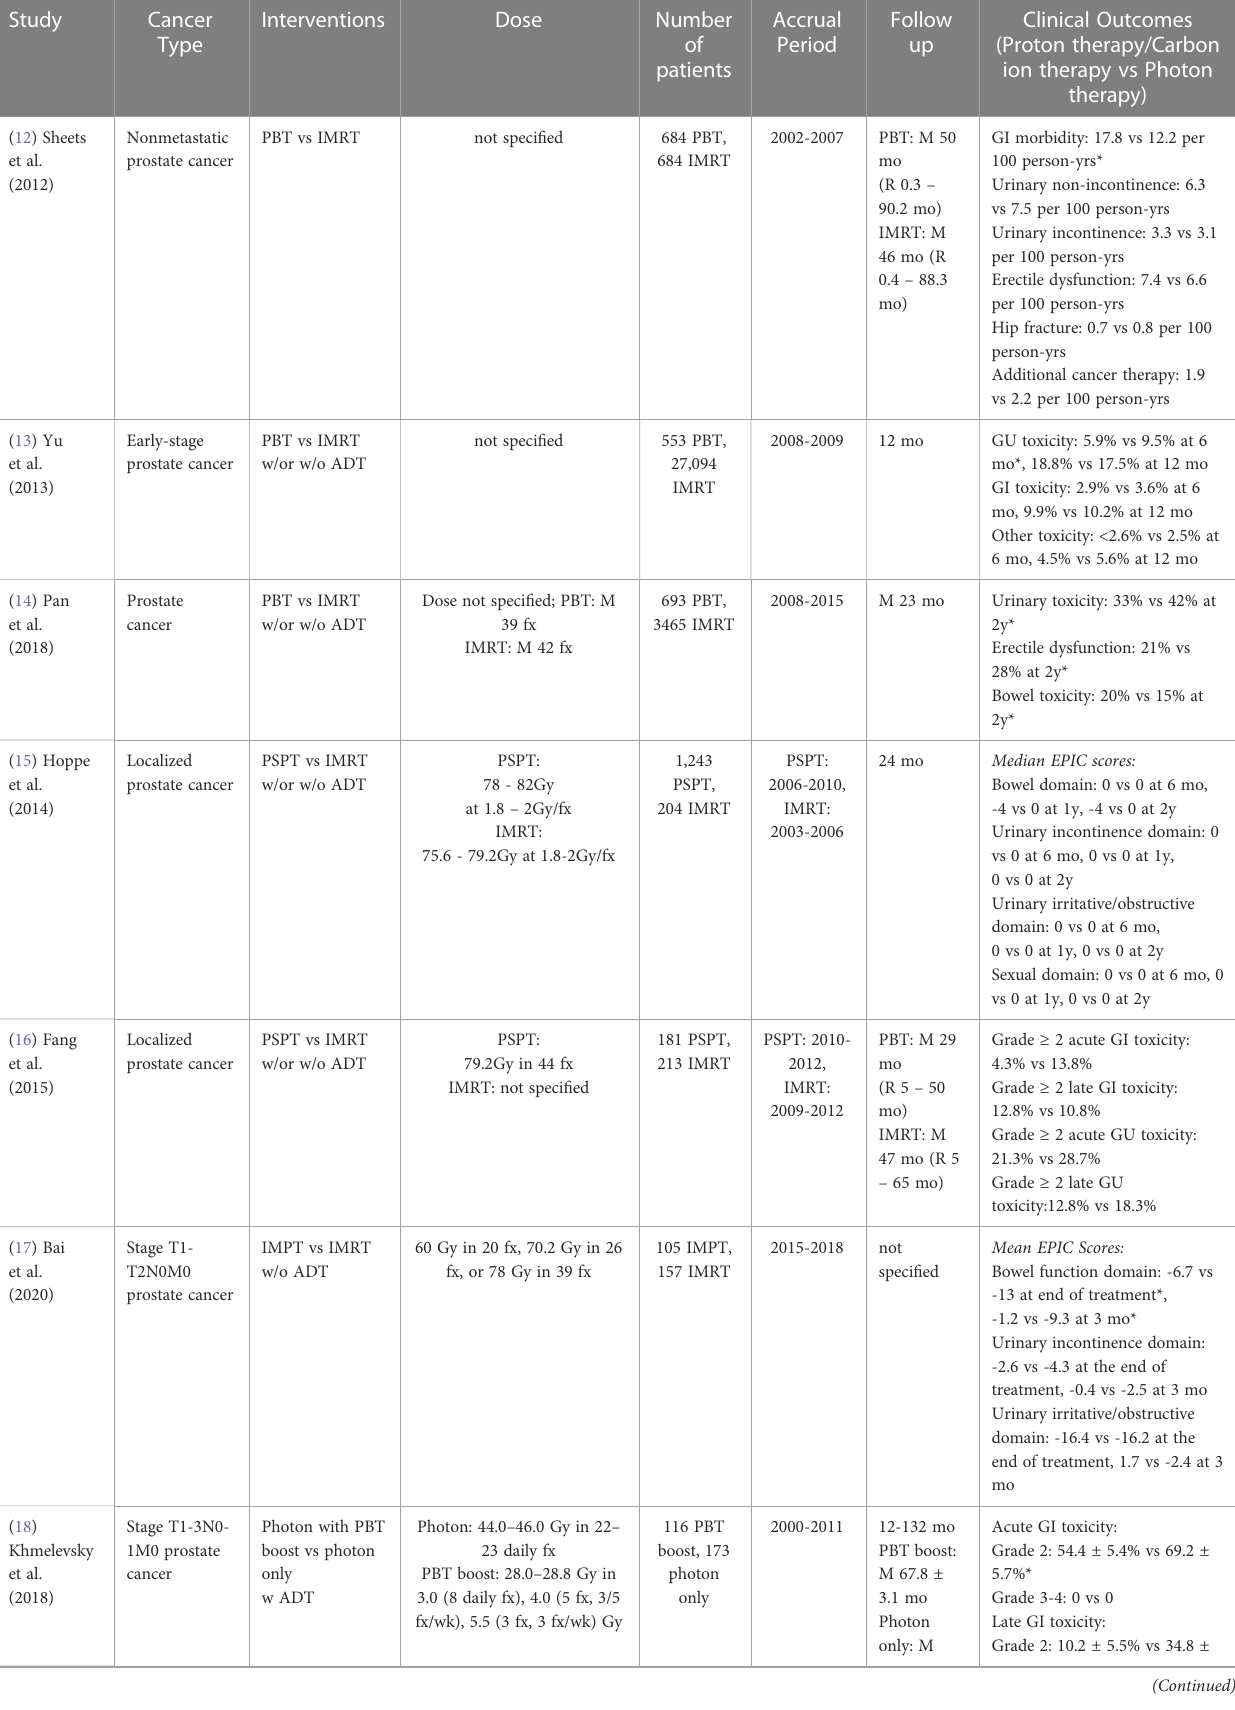
TABLE 1 Non-randomized clinical studies of proton versus photon radiation therapy – prostate